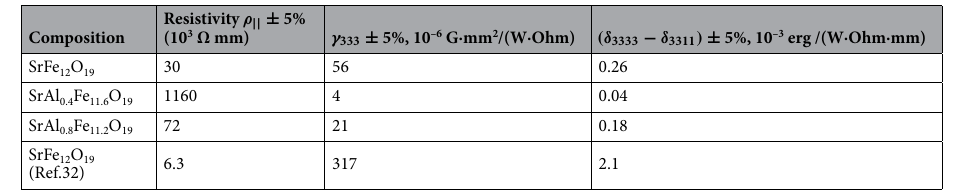
Table 2. Specific resistivity and nonlinear magnetoelectric coefficients for the Al-substituted